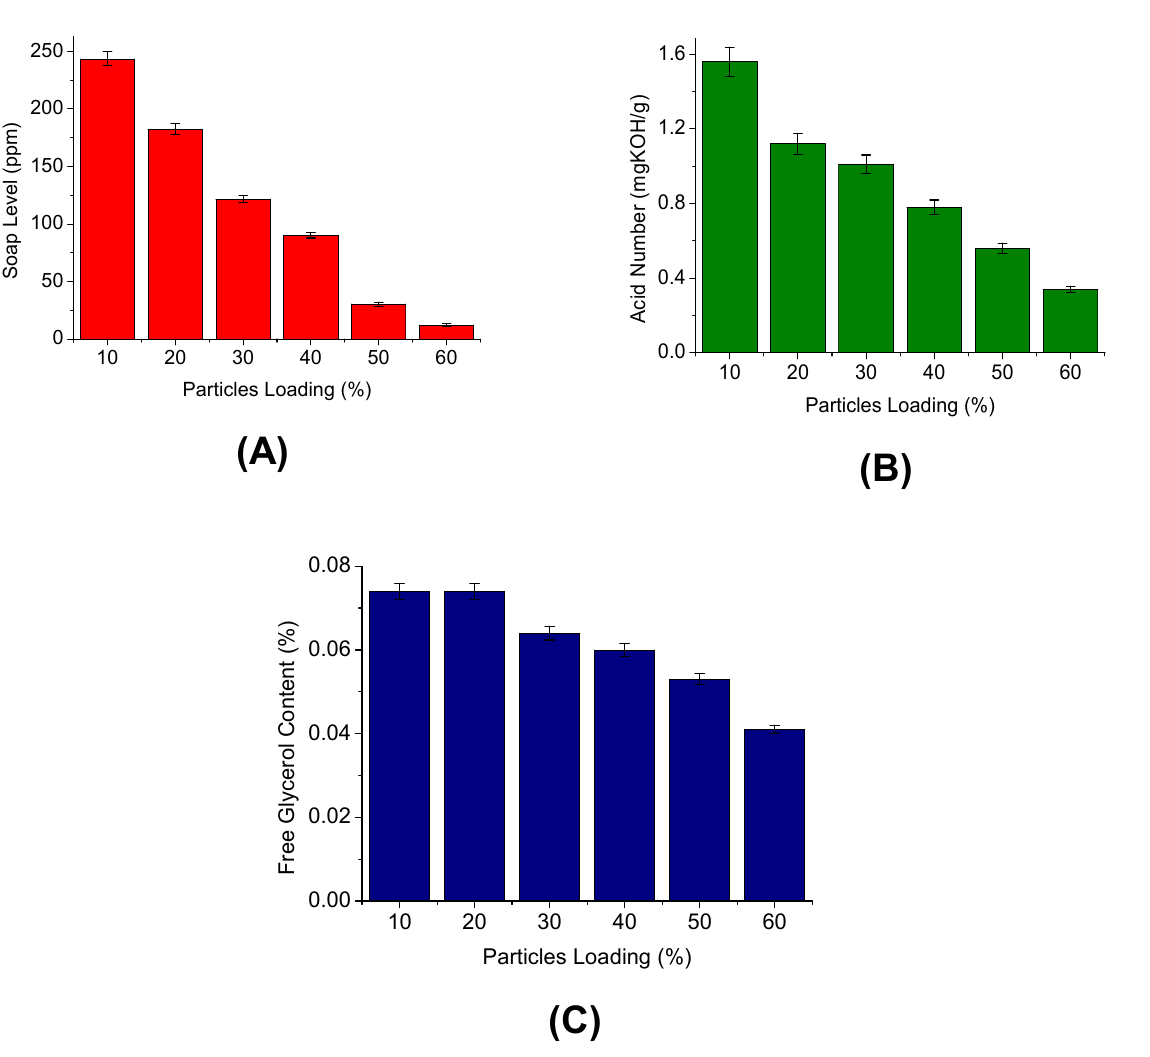
Figure 7. Effect of differences in loading silica particles on the quality of biodiesel: ( A ) soap level, ( B ) acid number, and ( C ) free glycerol content.